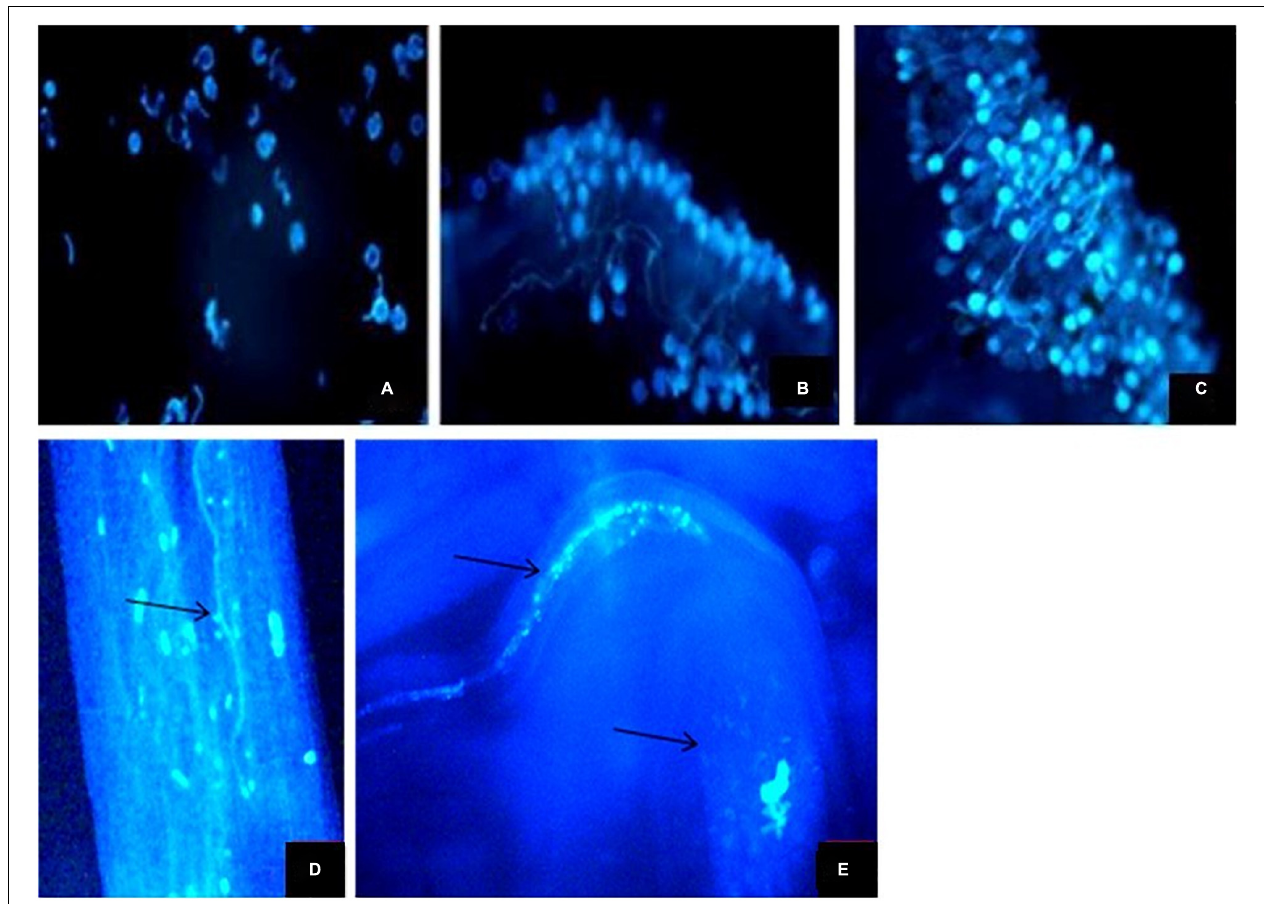
FIGURE 7 | | (A–E) Fluorescent micrographs of pollen grains. (A–C) Pollen germination on the stigma surface (D) Pollen tubes in style. (E) Pollen tubes entering